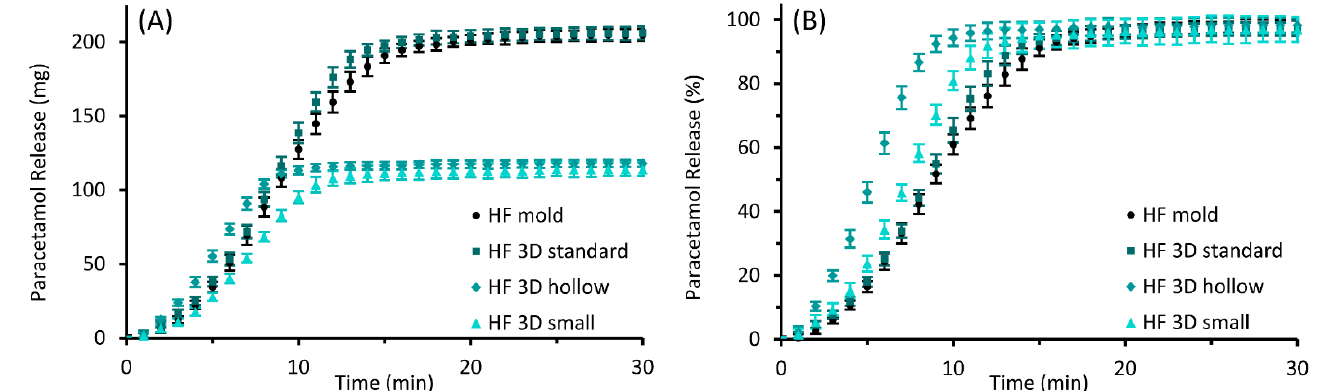
Figure 10. Paracetamol release profiles of molded and 3D printed (“standard”, “hollow”, and “small” design) suppositories based on HF; mean ± SD, n = 6. Diagram ( A ) shows the cumulative amount of the released drug as mass and diagram ( B ) as the proportion of the expected total amount of 10% ( w / w ) paracetamol of the individual suppository mass.